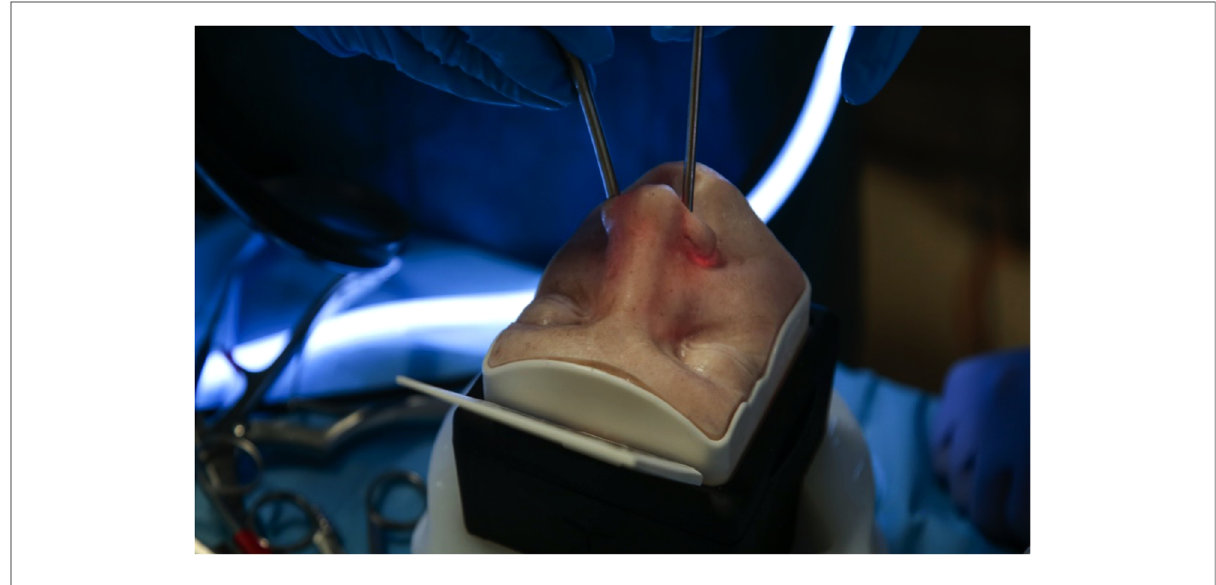
FIGURE 1 Upsurgeon TNS Box